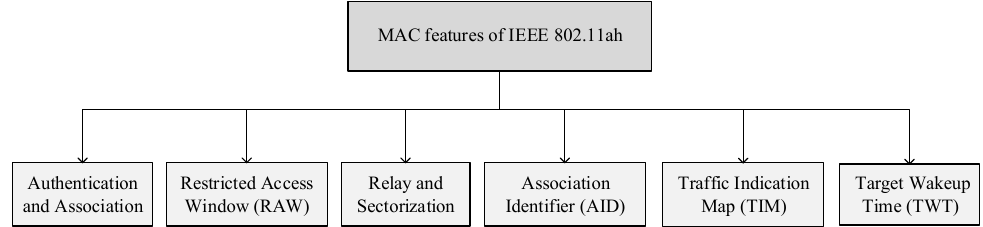
Figure 4. Categorization of the MAC layer features of the IEEE 802.11ah WLAN.